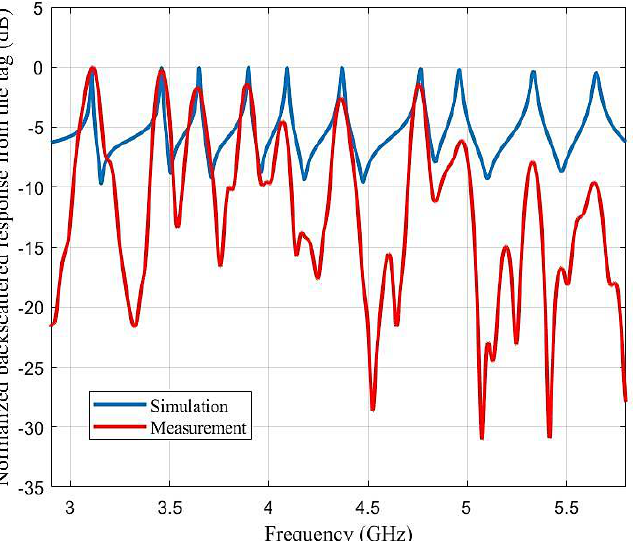
Figure 13. Simulation and measurement comparison of backscattered response from Tag 1 (Figure 12, red curve). Measurements were taken for the chipless reader, as discussed in [21].